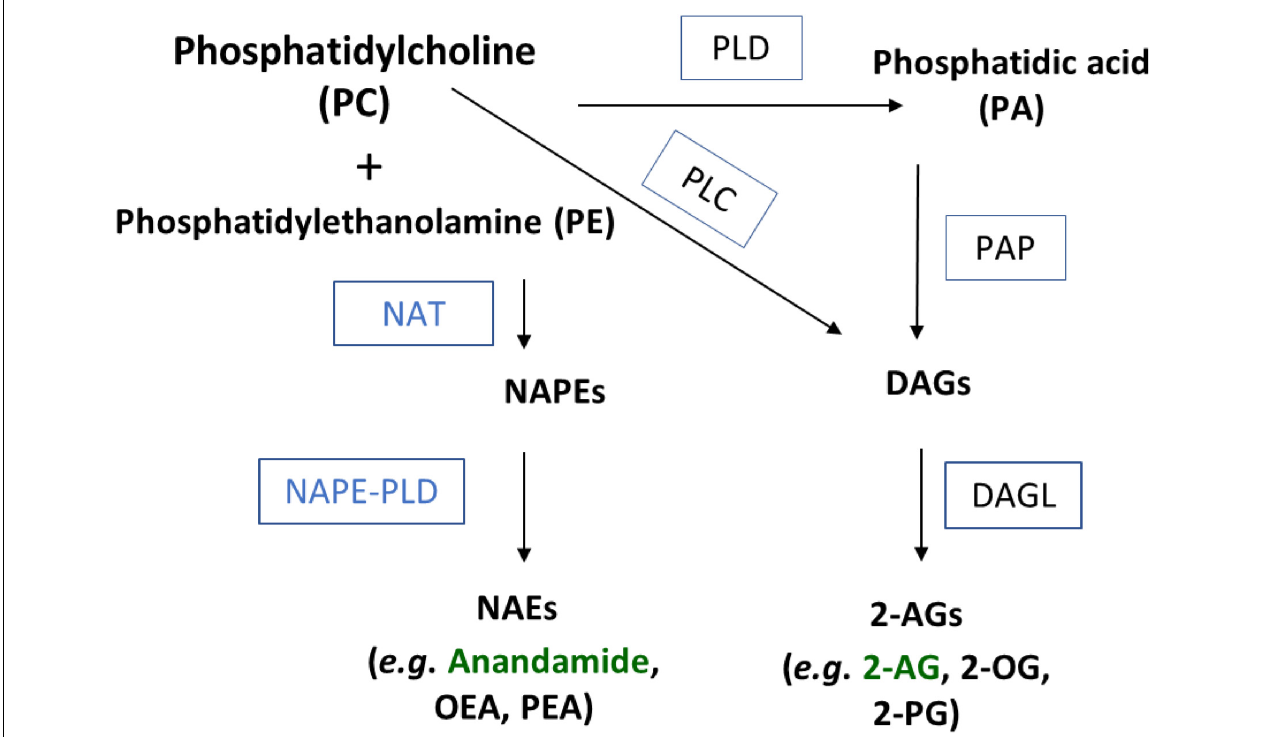
FIGURE 6 | Schematic of NAE and 2-acyl glycerol biosynthesis through a phosphatidylcholine (PC) precursor. Substrates and products in bold black. Enzymes abbreviated in boxes. NAT, N-acyl transferase; PLD, phospholipase D; PLC, phospholipase C; PA, phosphatidic acid; NAPE, N-acyl phosphatidylethanolamine; PAP, phosphatidic acid phosphohydrolase; DAG, diacylglycerol; DAGL, diacylglycerol